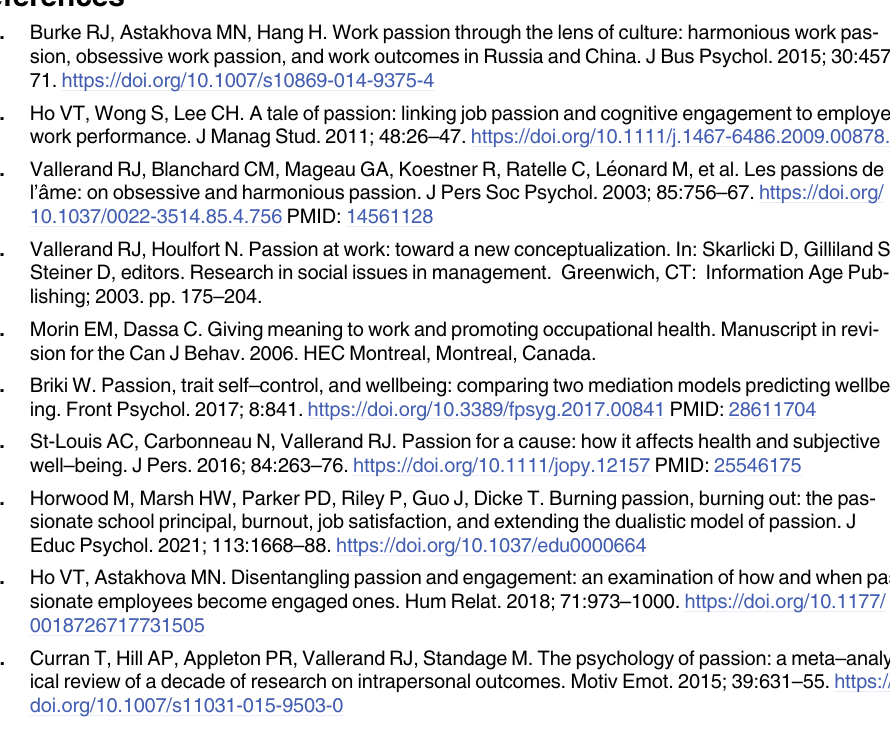
S1 Table. The means, standard deviations, and correlations between